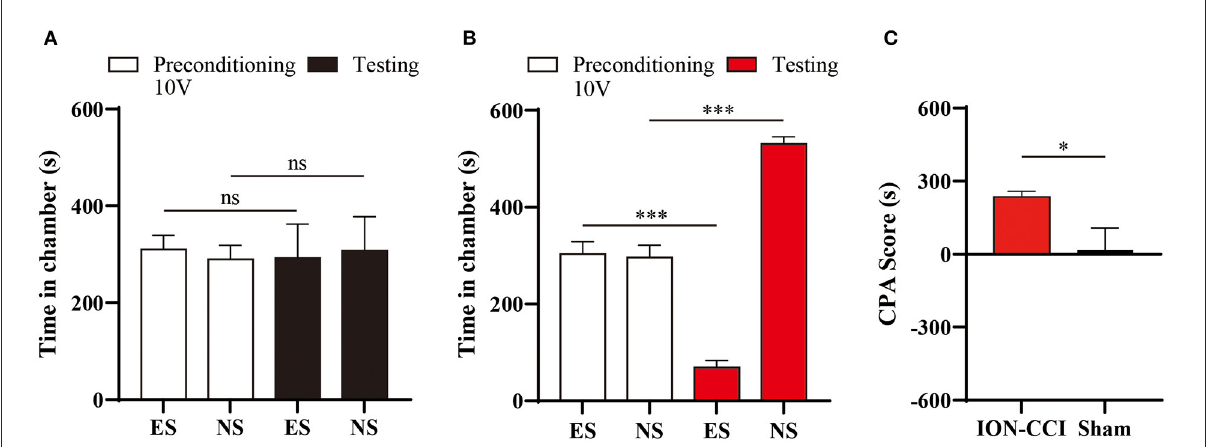
FIGURE7 Enhancement of aversion to electrical stimuli induced by neuropathic orofacial pain. (A) Sham group rats did not display significant avoidance to the chamber paired with 10V electrical stimuli (ES). (B) ION-CCI rats demonstrated significant aversive response to the chamber paired with ES during the testing phase during the CPA experiments. *** p < 0.001, paired Student’s t -test. (C) Comparison of CPA score between ION-CCI and sham group. * p < 0.05, unpaired Student’s t